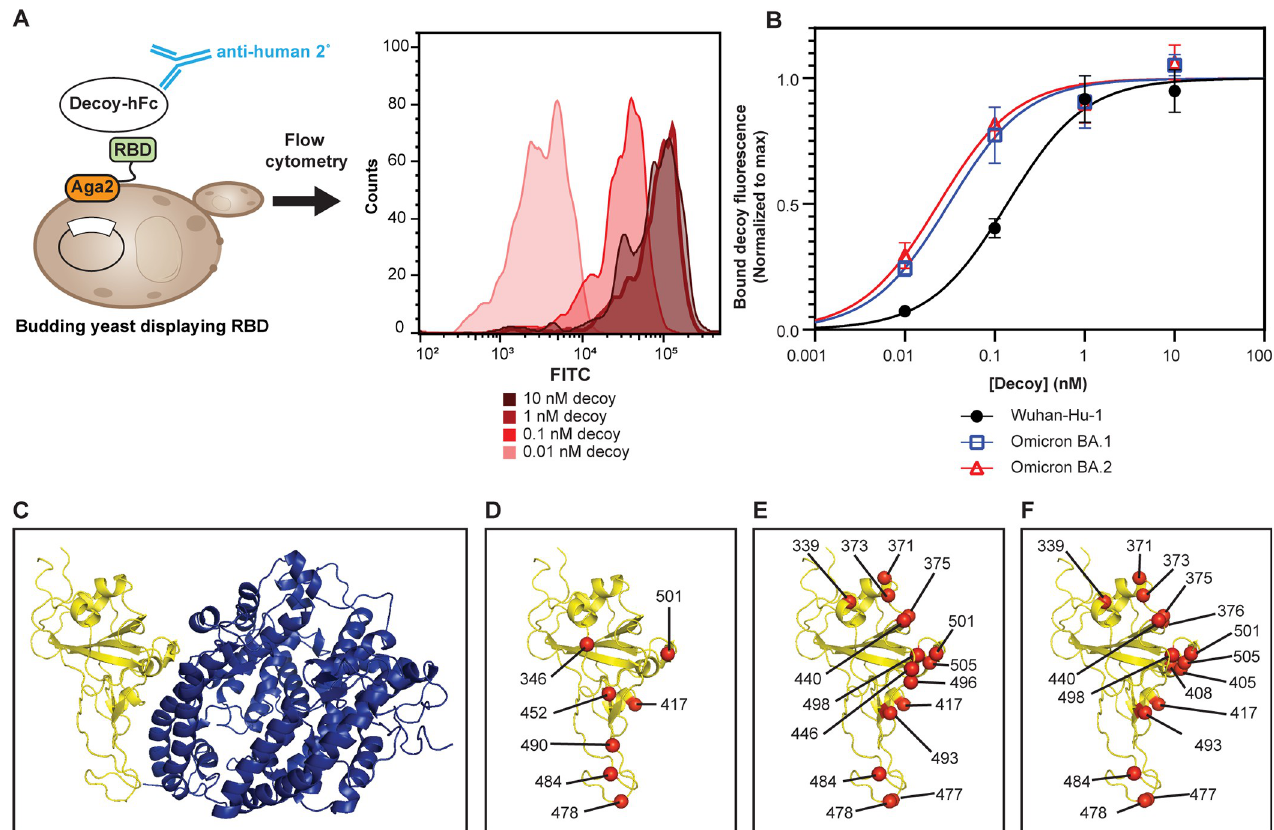
Fig 1. CDY14HL maintains tight binding to diverse SARS-CoV-2 variants. (A) Scheme for measuring decoy binding to yeast surface-expressed RBDs. Histograms are from a representative replicate of decoy binding to yeast-displayed Wuhan-Hu-1 RBD. (B) Representative decoy binding data for the RBD from the ancestral (Wuhan-Hu-1) SARS-CoV-2 strain and both Omicron variants. (C) The complex [34] between the SARS-CoV-2 Wuhan-Hu-1 RBD (yellow ribbons) and human ACE2 (blue ribbons). (D) The Wuhan-Hu-1 RBD from the ACE2 complex structure is shown alone. Red spheres indicate the α -carbon of amino acid residues mutated in several pre-Omicron SARS-CoV-2 variant strains. Amino acid position numbers are shown for each mutated residue. These mutations cluster around the interface with ACE2. Wuhan-Hu-1 RBD is shown with the positions mutated in Omicron BA.1 (E) and Omicron.BA.2 (F) in red spheres. Error bars represent standard deviation of at least four replicate